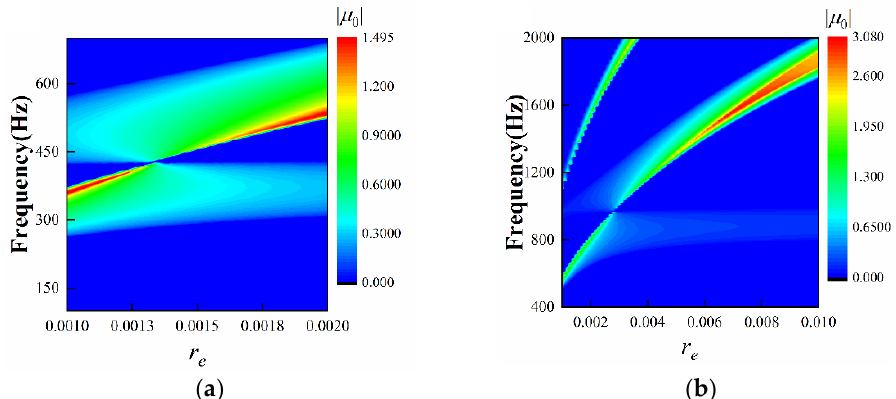
Figure 7. Effects of the ratio r e on the attenuation performance of flexural waves: ( a ) with fluid loading; ( b ) without fluid loading.